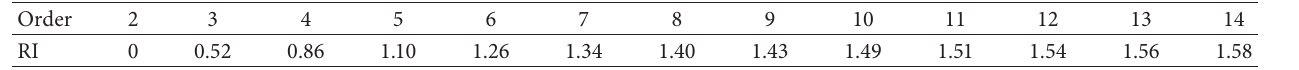
Table 3: The mean random consistency index [43,